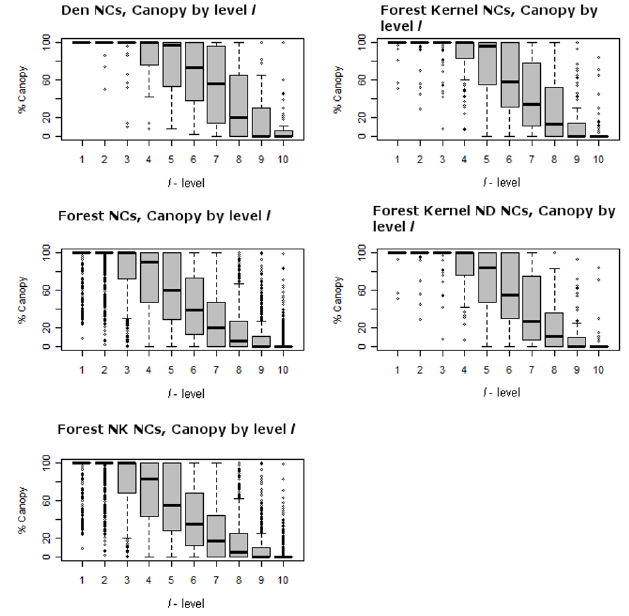
Figure 6. Canopy distributions over each k -Max- l level for each spatial distribution set. NC spatial sets are from top left to right: den, kernel, forest, forest excluding den sites, and forest excluding kernel. Solid bar represents the median, gray box represents the 25% quartile above and below the mean, and the whiskers represent 3.5 times the upper and lower values of the gray box. The dots are individual values that lie outside the whiskers.